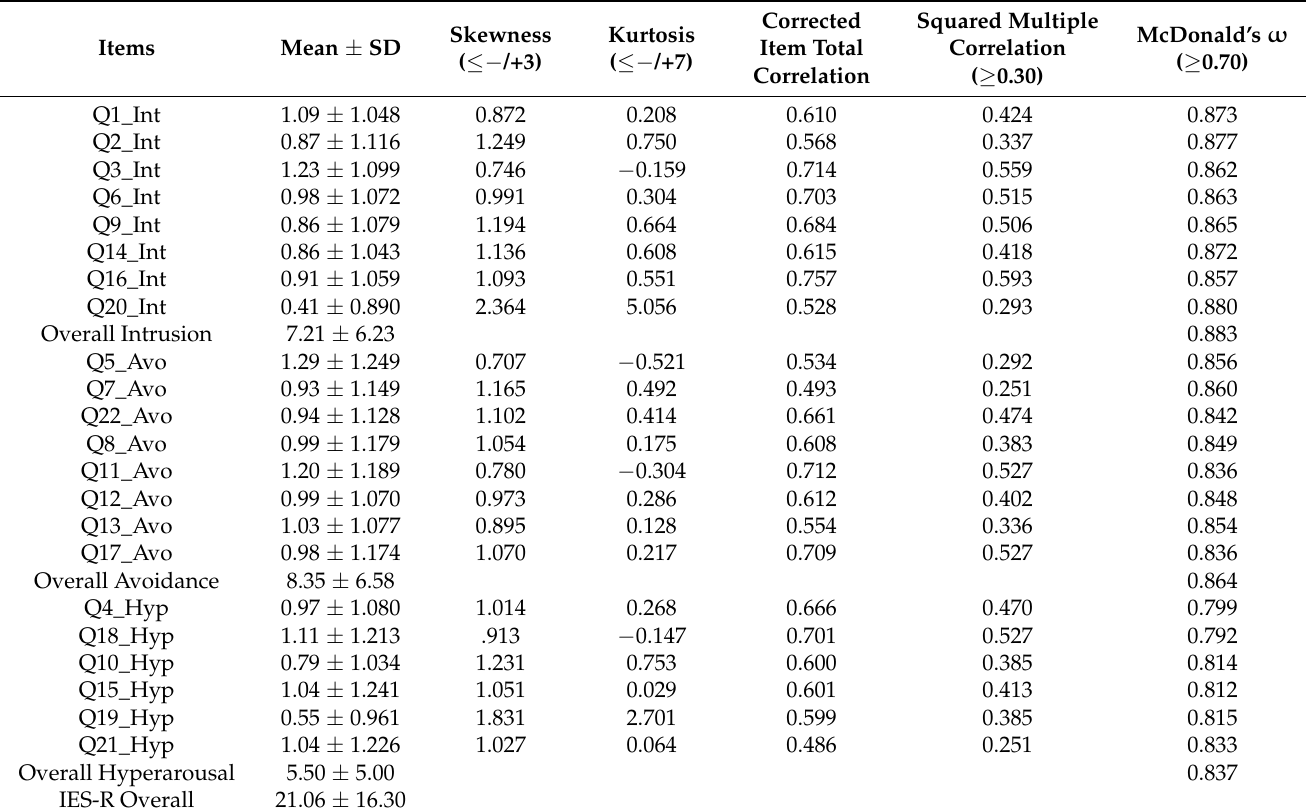
Table 3. Descriptive statistics, normality, and internal consistency of the items of the Impact of Event Scale-Revised (IES-R).